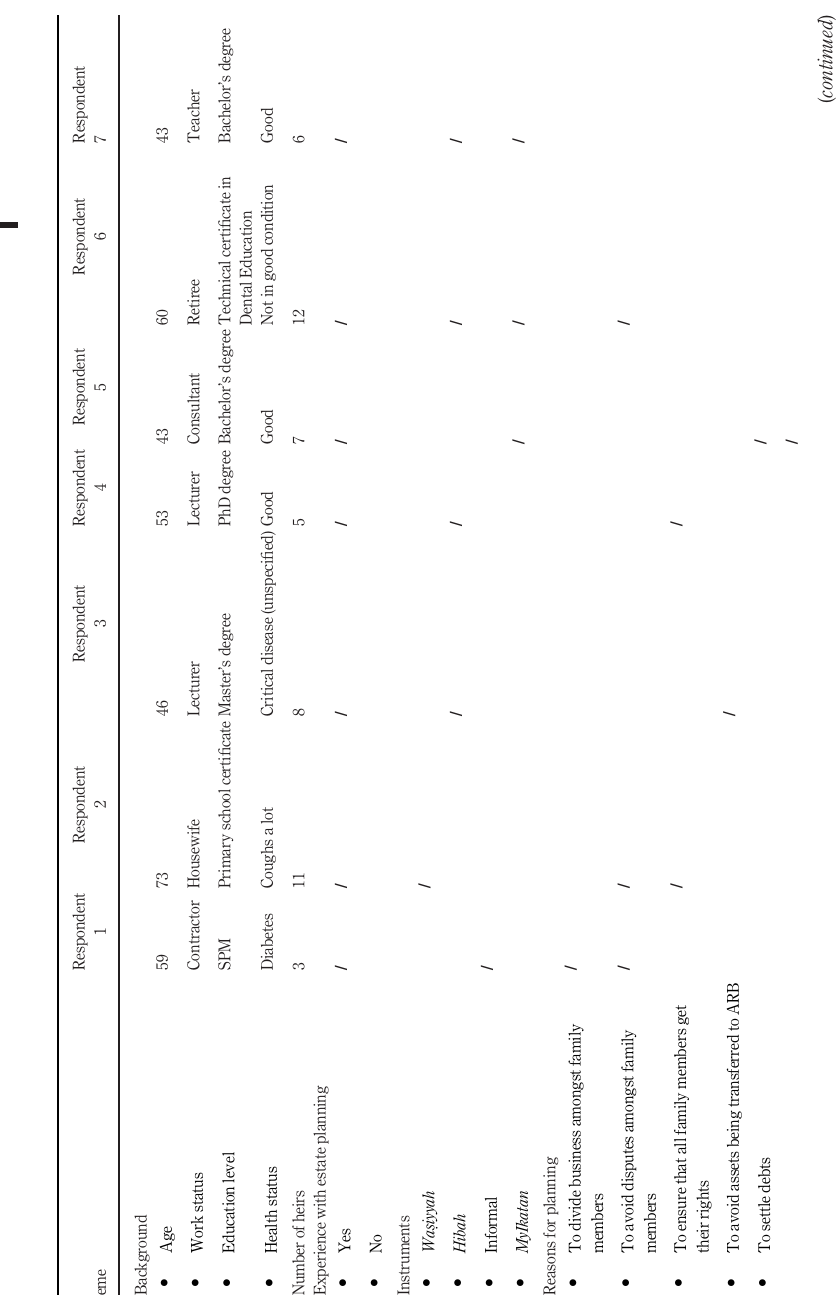
Table 1. Background of the